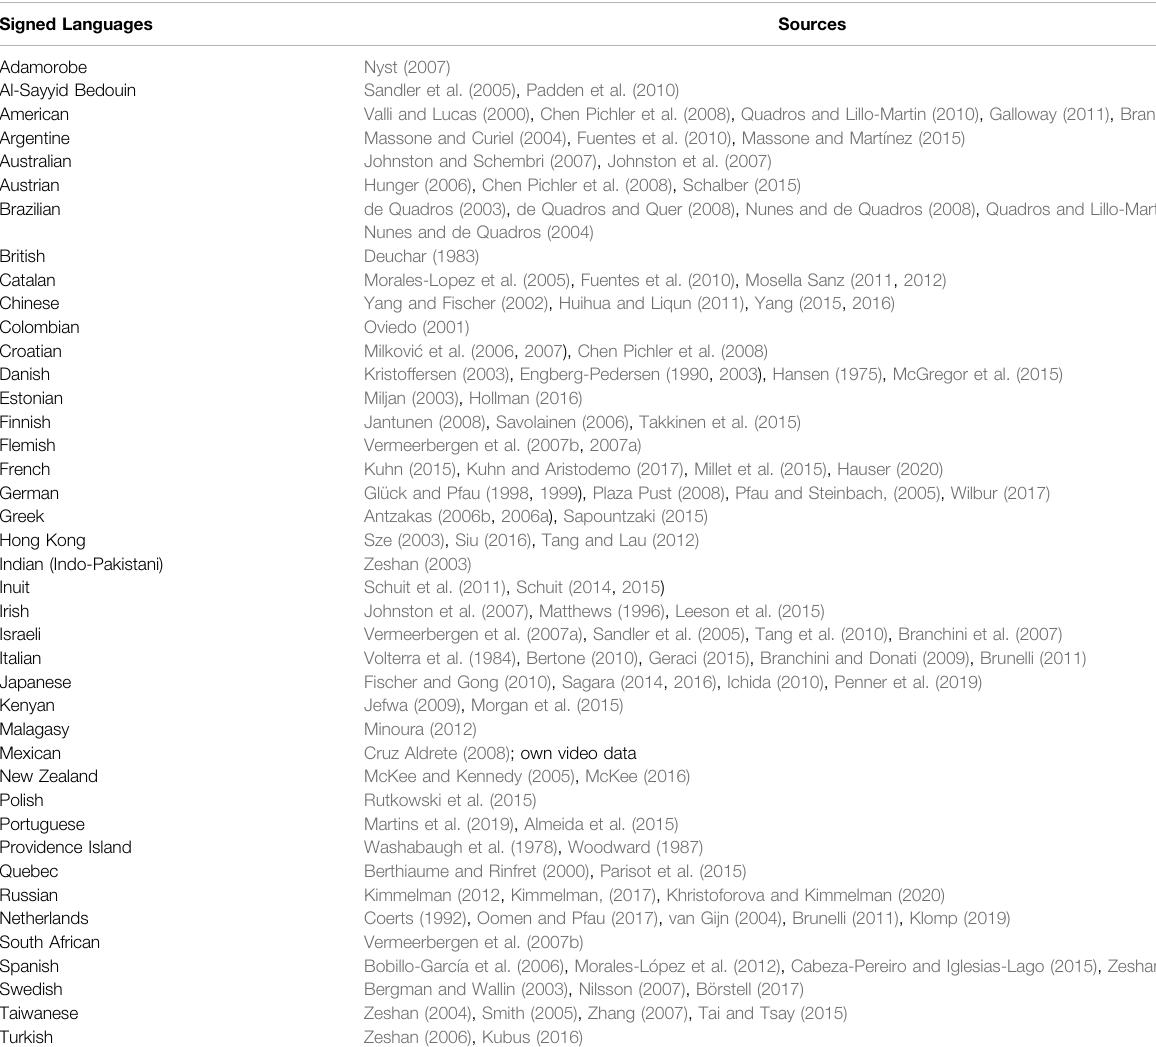
TABLE 1 | Signed languages in the study and